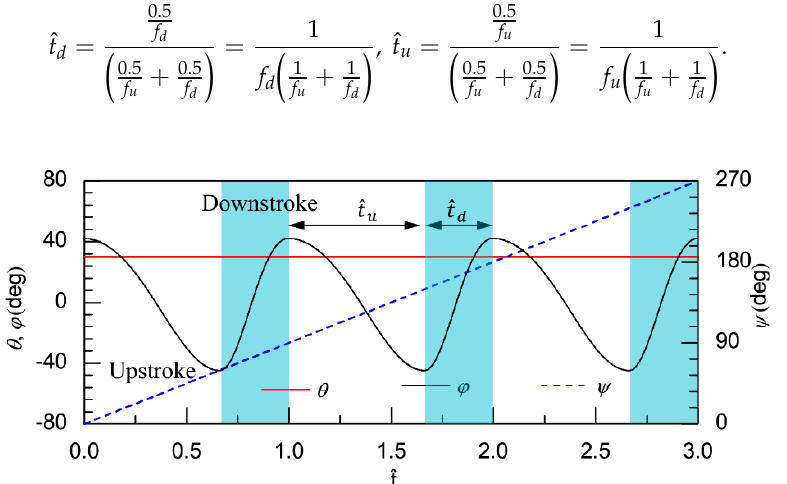
Figure 5. Time-course curves of stroking, twisting, and rotary angles in three flapping periods .